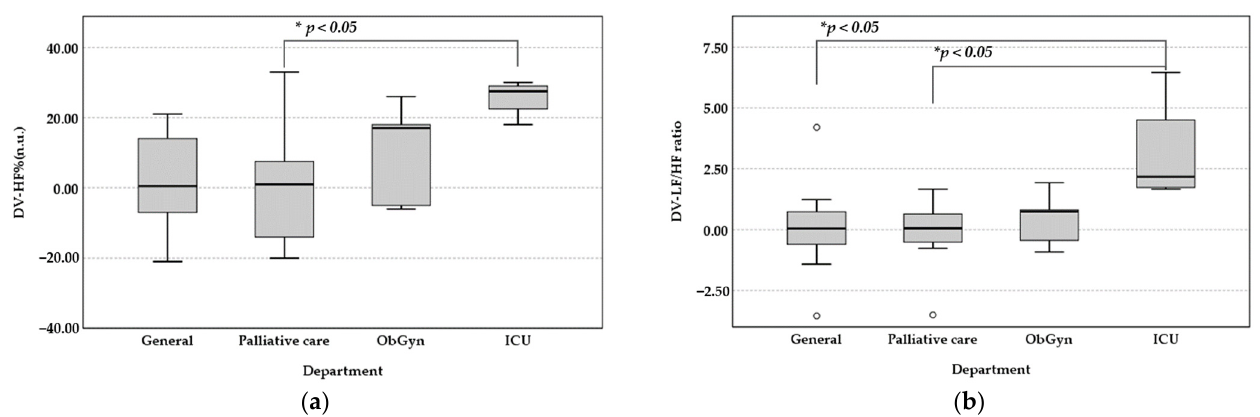
Figure 4. Pre-post difference value of physiological indicators: ( a ) HF%; ( b ) LF/HF ratio. (* p < 0.05)